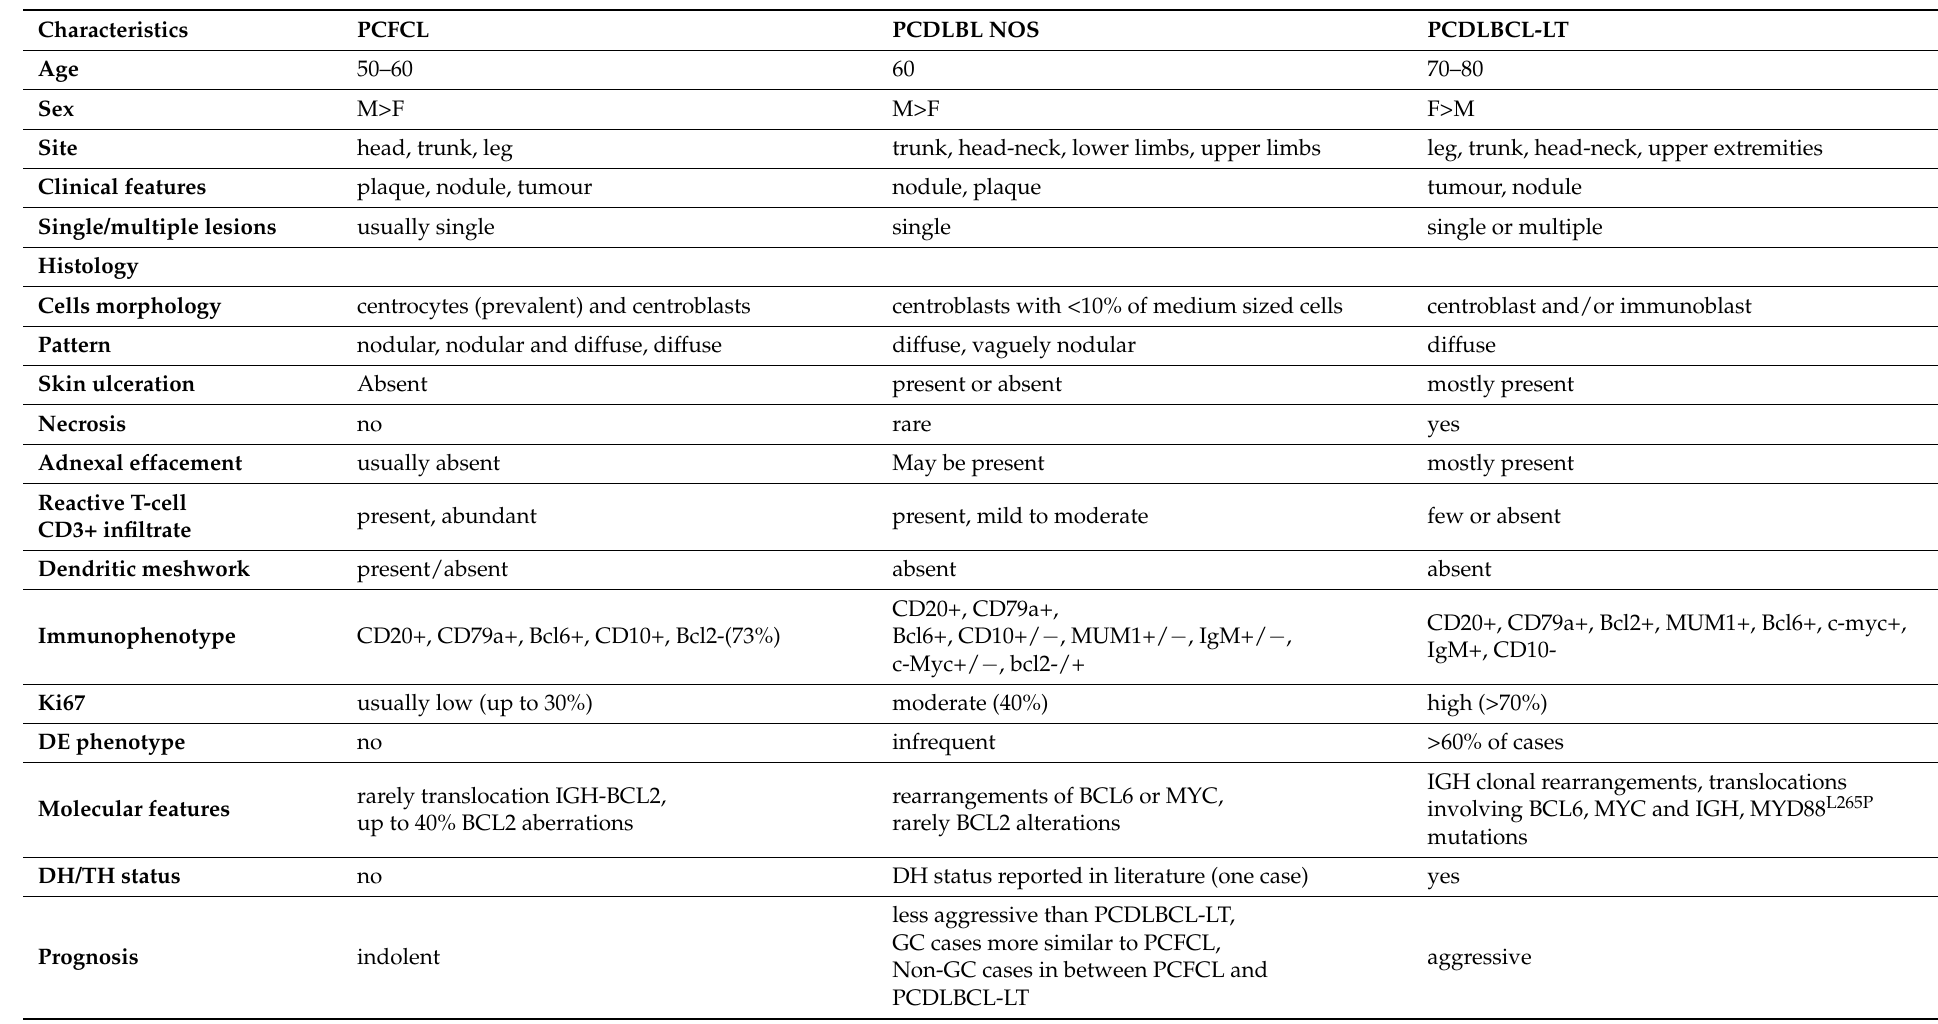
Table 2. Differential diagnosis between PCFCL, PCDLBCL NOS and